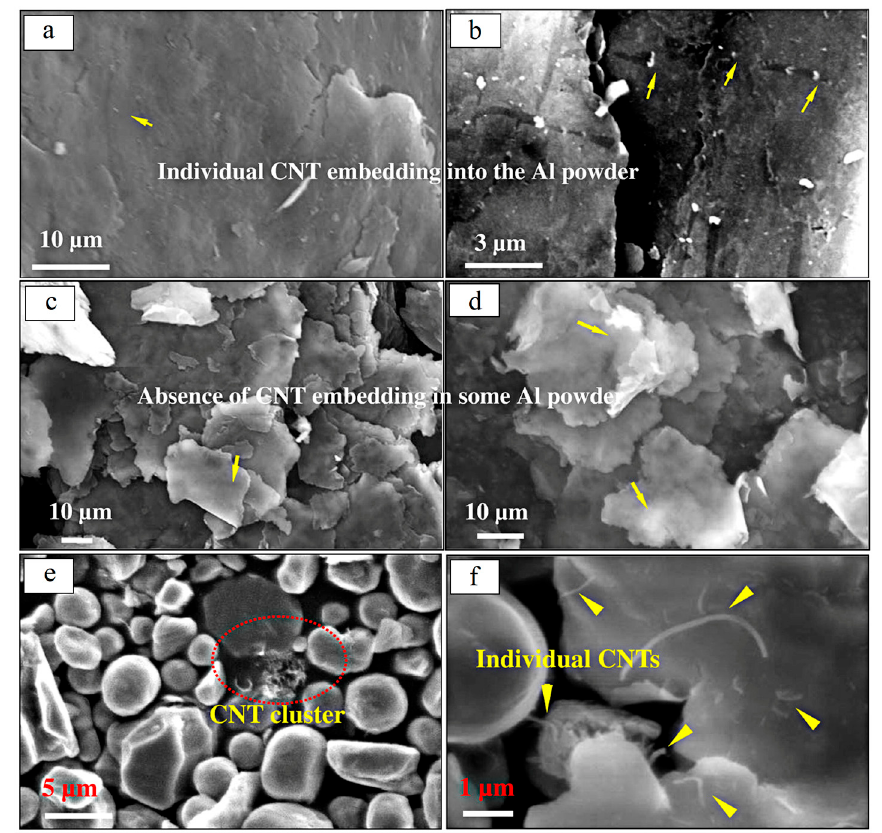
Figure 5. SEM images of a CNT-Al blend after milling by high energy milling ( a – d ) and low energy milling ( e , f ) [85]. The CNTs are uniformly dispersed and embedded in Al powders during high energy ball milling, as shown by yellow arrows. (Reproduced with permission from [85], Elsevier, 2011.)